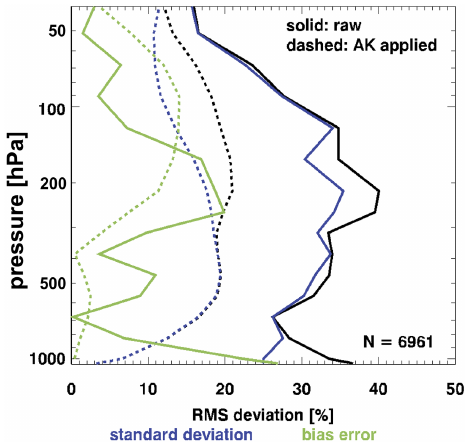
Figure 7. The rms deviation, standard deviation of the mean bias, and bias error of the IASI-TOE profiles with respect to raw ozone sonde profiles (solid lines) and after the averaging kernels (AK) have been applied (dashed lines). The standard deviation represents the precision of the IASI measurements (and also that of the ozone sondes) whereas the rms deviation is the square root of the sum of the squared precision and the squared bias.